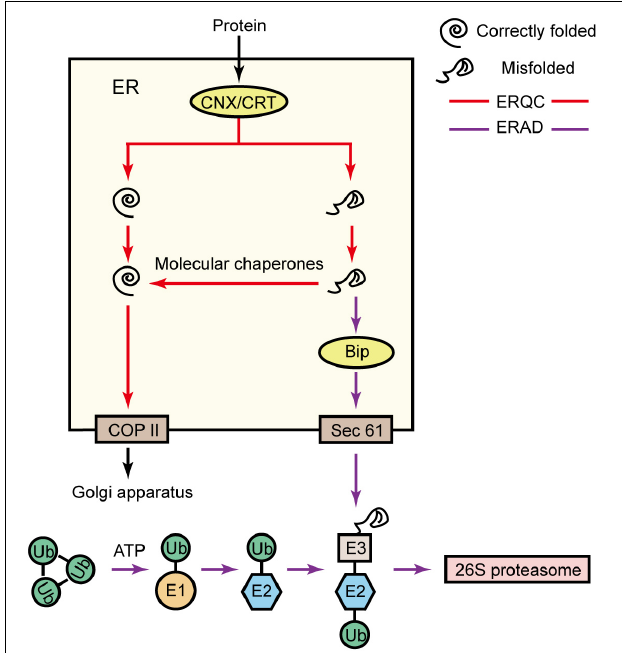
FIGURE 8 | Protein synthesis response mechanism. In the endoplasmic reticulum, the ERQC proteins CNX and CRT detect the folding of proteins. Correctly folded proteins will be transported from COP II to the Golgi apparatus for further processing. However, misfolded proteins are refolded by recruited molecular chaperones. Alternatively, the ERAD system can also identify misfolded proteins via BiP, transport misfolded proteins from Sec61 to the cytoplasm, and mediate ubiquitination-based degradation to prevent the accumulation of misfolded proteins in the endoplasmic reticulum. The ubiquitin-mediated degradation process is as follows: a ubiquitin-activating enzyme (E1) activates a ubiquitin molecule (Ub), with ATP supplying the required energy; the activated Ub is transferred to a ubiquitin-binding enzyme (E2); a ubiquitin ligase (E3) connects Ub-E2 to the target protein; and the ubiquitinated target protein is specifically recognized by the 26S proteasome and degraded (Ruggiano et al.,